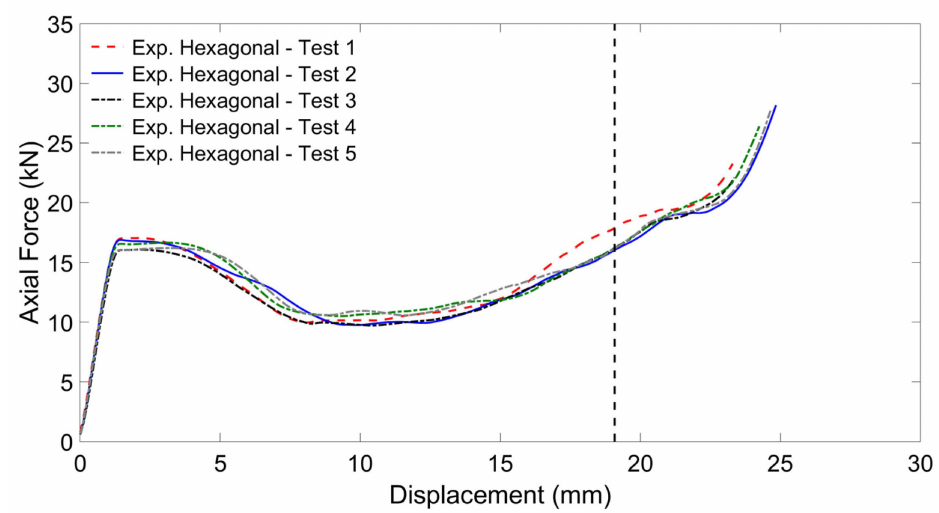
Figure 13. Force-displacement experimental curves of the regular-scale specimens constituted by the hexagonal cell geometry and undergoing axial load.